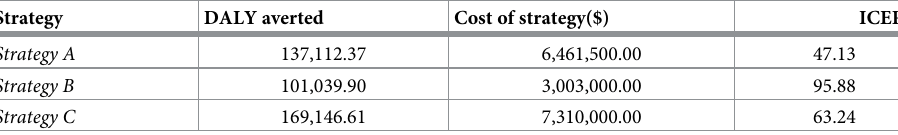
Table 11. ICER of control strategies in the order of DALY averted. Strategy